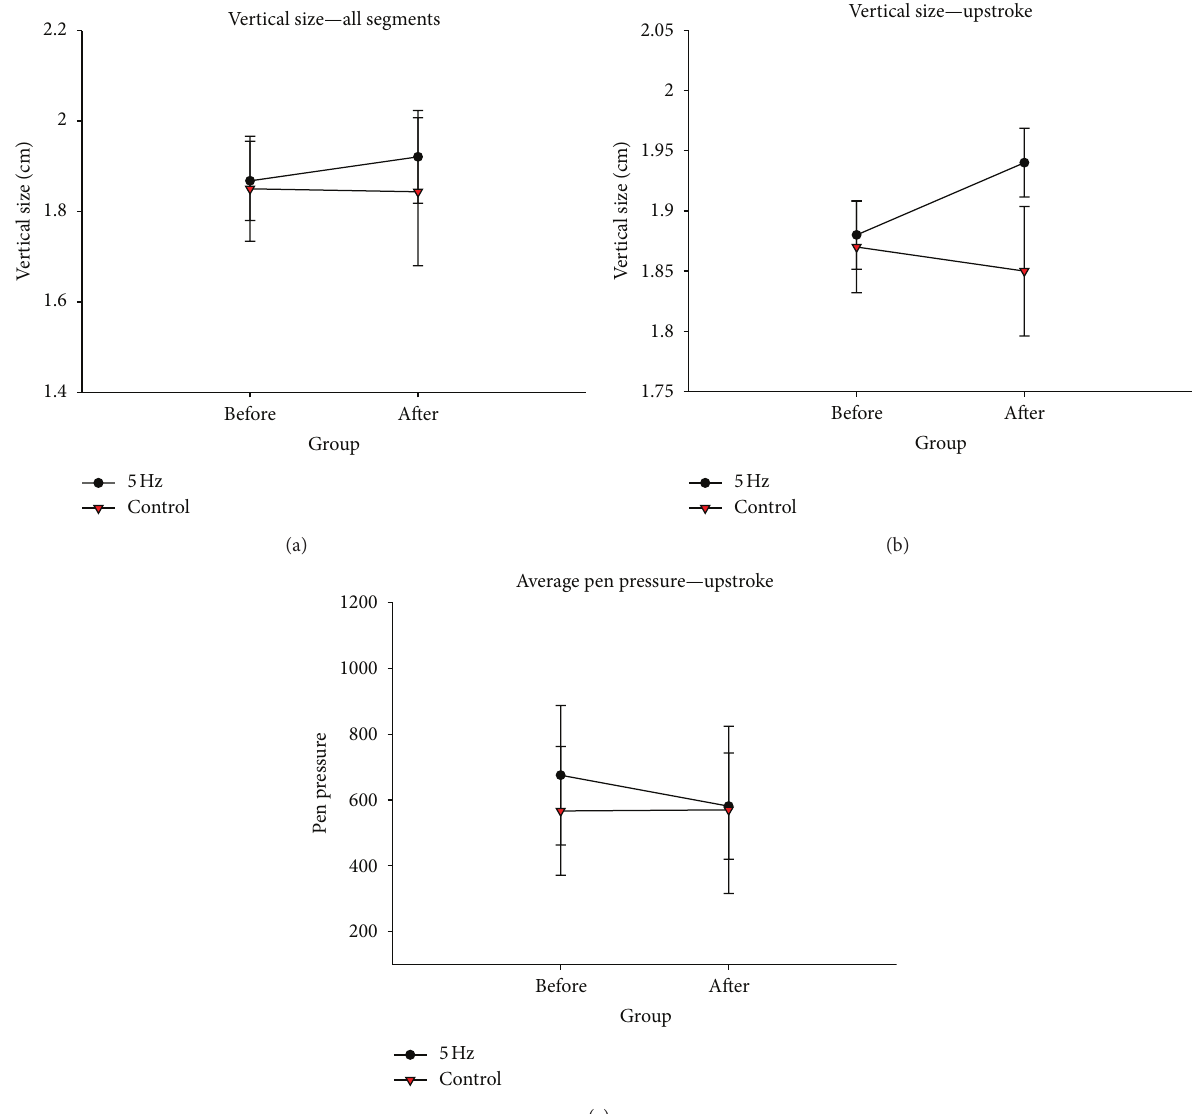
Figure 3: Significant interactions in behavioural data from handwriting task for (a) vertical size, (b) upstroke size, and (c) average pen pressure. Error bars are standard error of the mean (SEM).